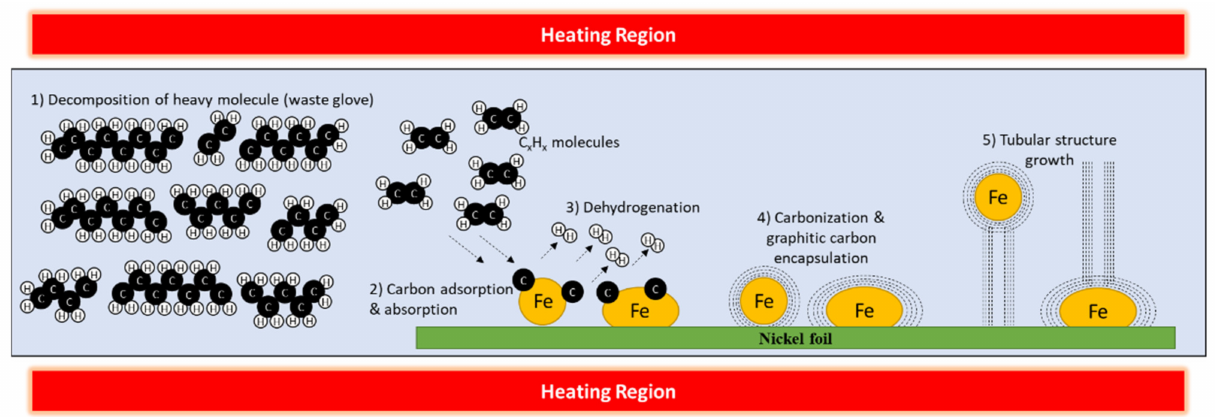
Figure 13. Illustration of the suggested growth mechanism of CNTs during the CVD